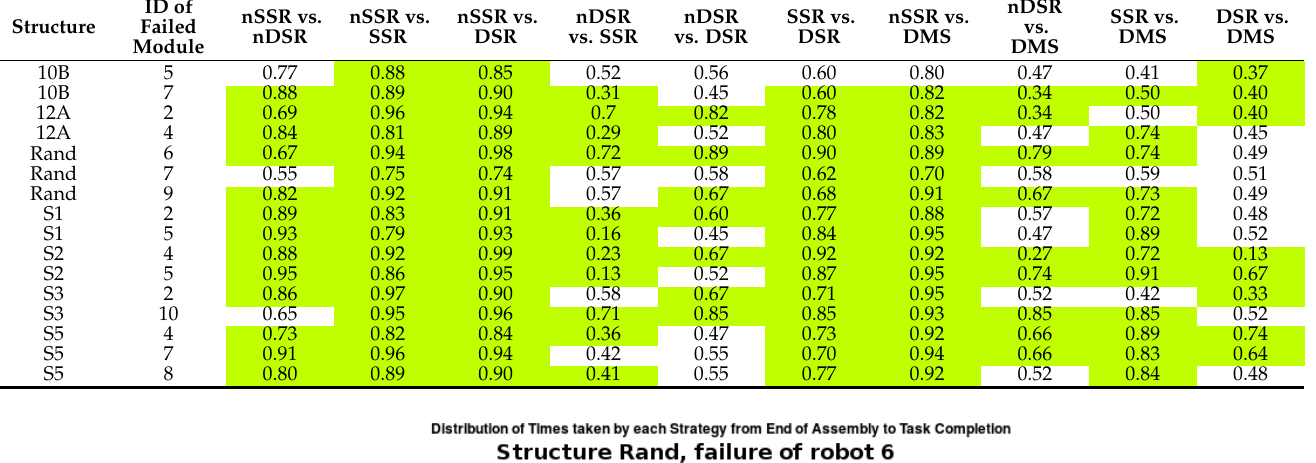
Table 5. A-test results showing effect sizes of the differences between distributions of total task- completion times. For each column of Strategy A vs Strategy B, results show the chance that A will take longer than B. Green cells mark those for which the p -value indicated a statistically significant difference in strategy performance. In all statistically significant examples, nSSR is inferior, slower, than all other strategies. DSR and nDSR are often faster than SSR, with some exceptions where SSR outpaces nDSR. Furthermore, nDSR and DSR usually have similar performance, but where they are statistically significantly different, DSR proves faster. DSR with DMS proves statistically significantly different to nSSR in almost all scenarios, whilst differing from DSR and nDSR in fewer scenarios. DMS is faster than nDSR for a majority of scenarios and slower than standard DSR for more than half of the statistically different scenarios.